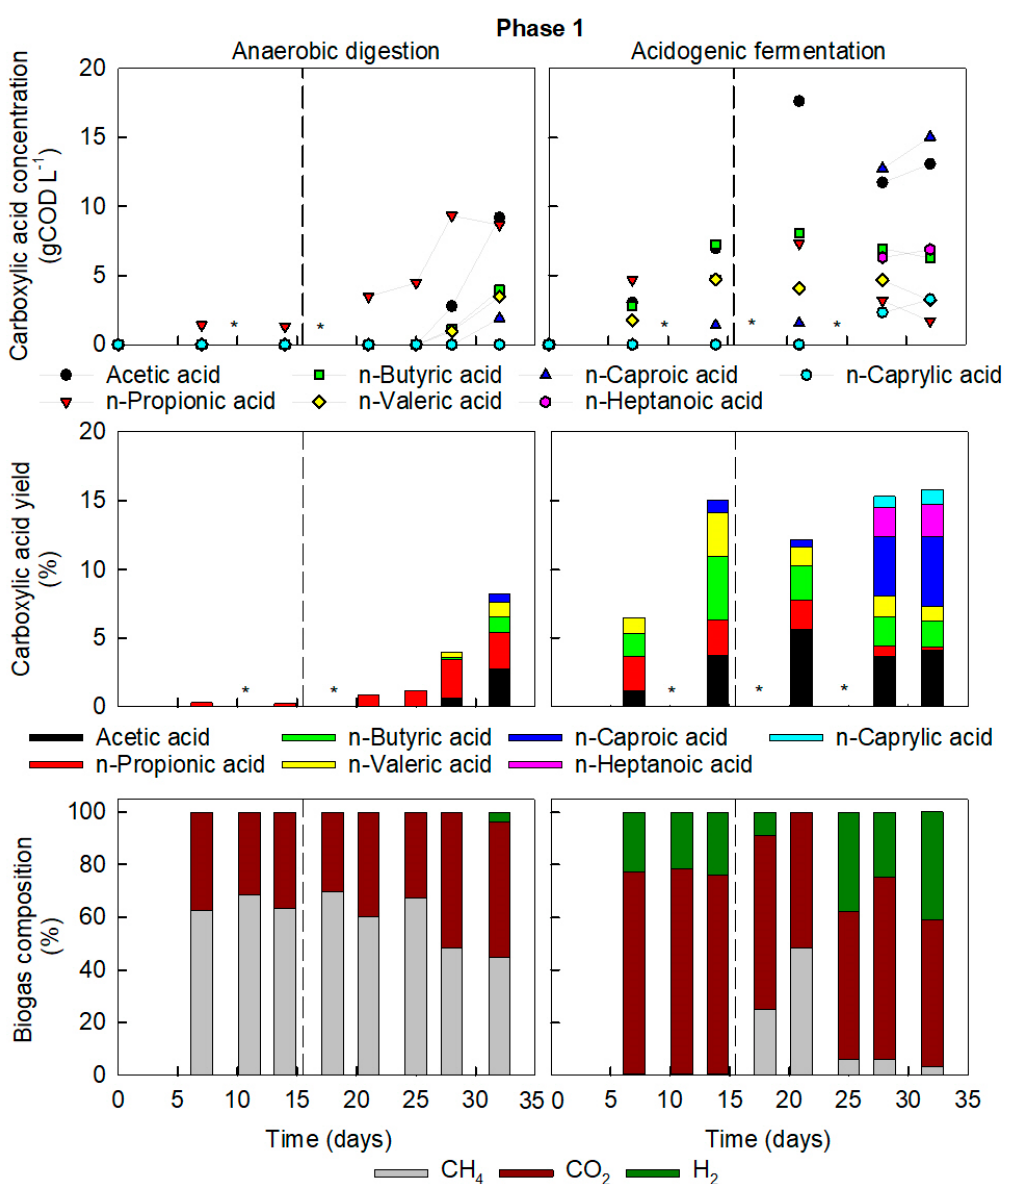
Figure 1. Key chemical compounds in Phase 1 of reactor operation in AD ( left ) and AF ( right ). Concentrations ( top ) and yields ( middle ) of liquid fermentation compounds and biogas composition ( bottom ). Dashed lines represent change of feed from FW1 to FW2. * Not determined.